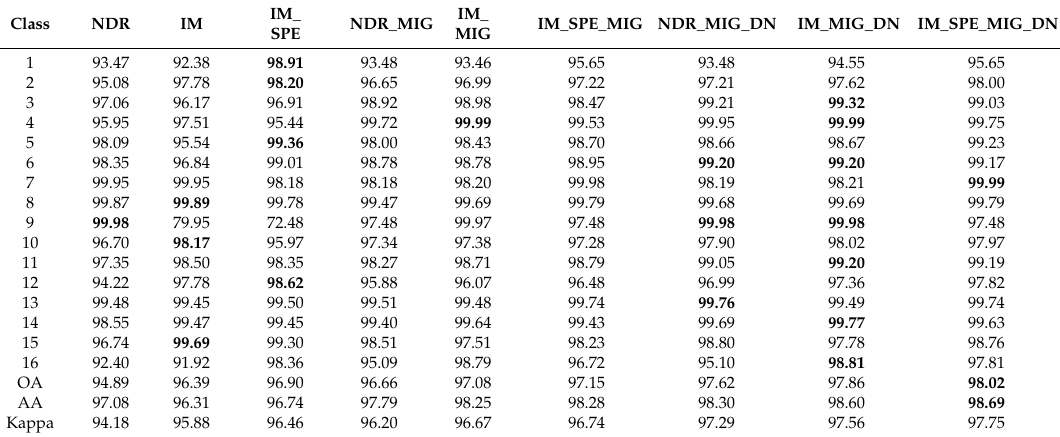
From Table 3, on the Indian Pines dataset, the three classification evaluation indicators (OA, AA,